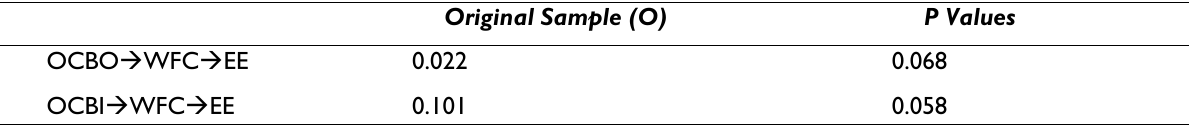
Table 5. Indirect